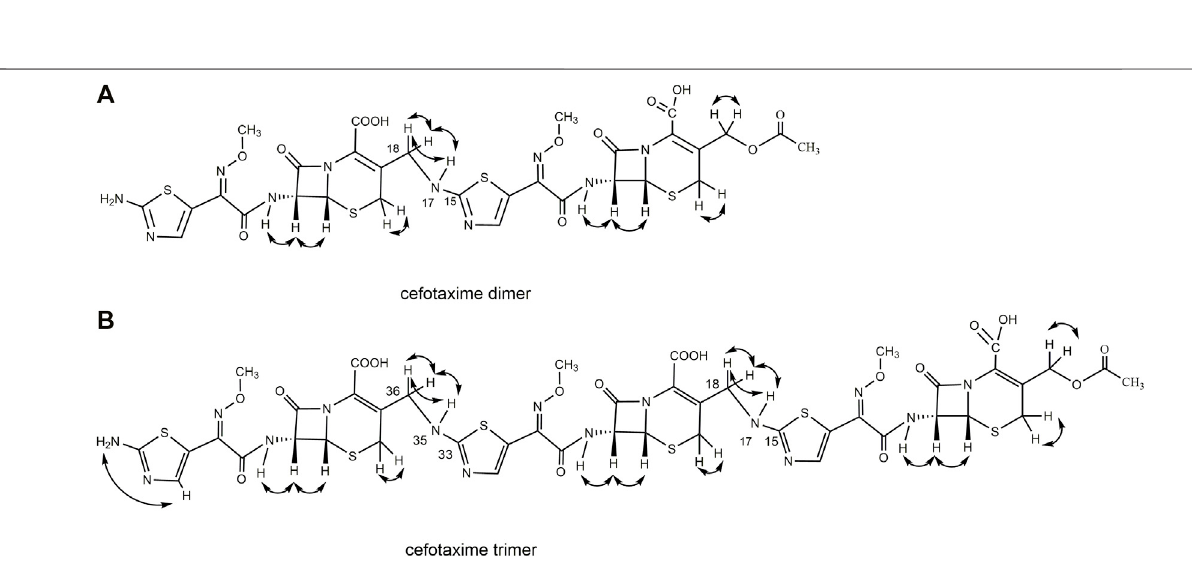
Frontiers in Chemistry |